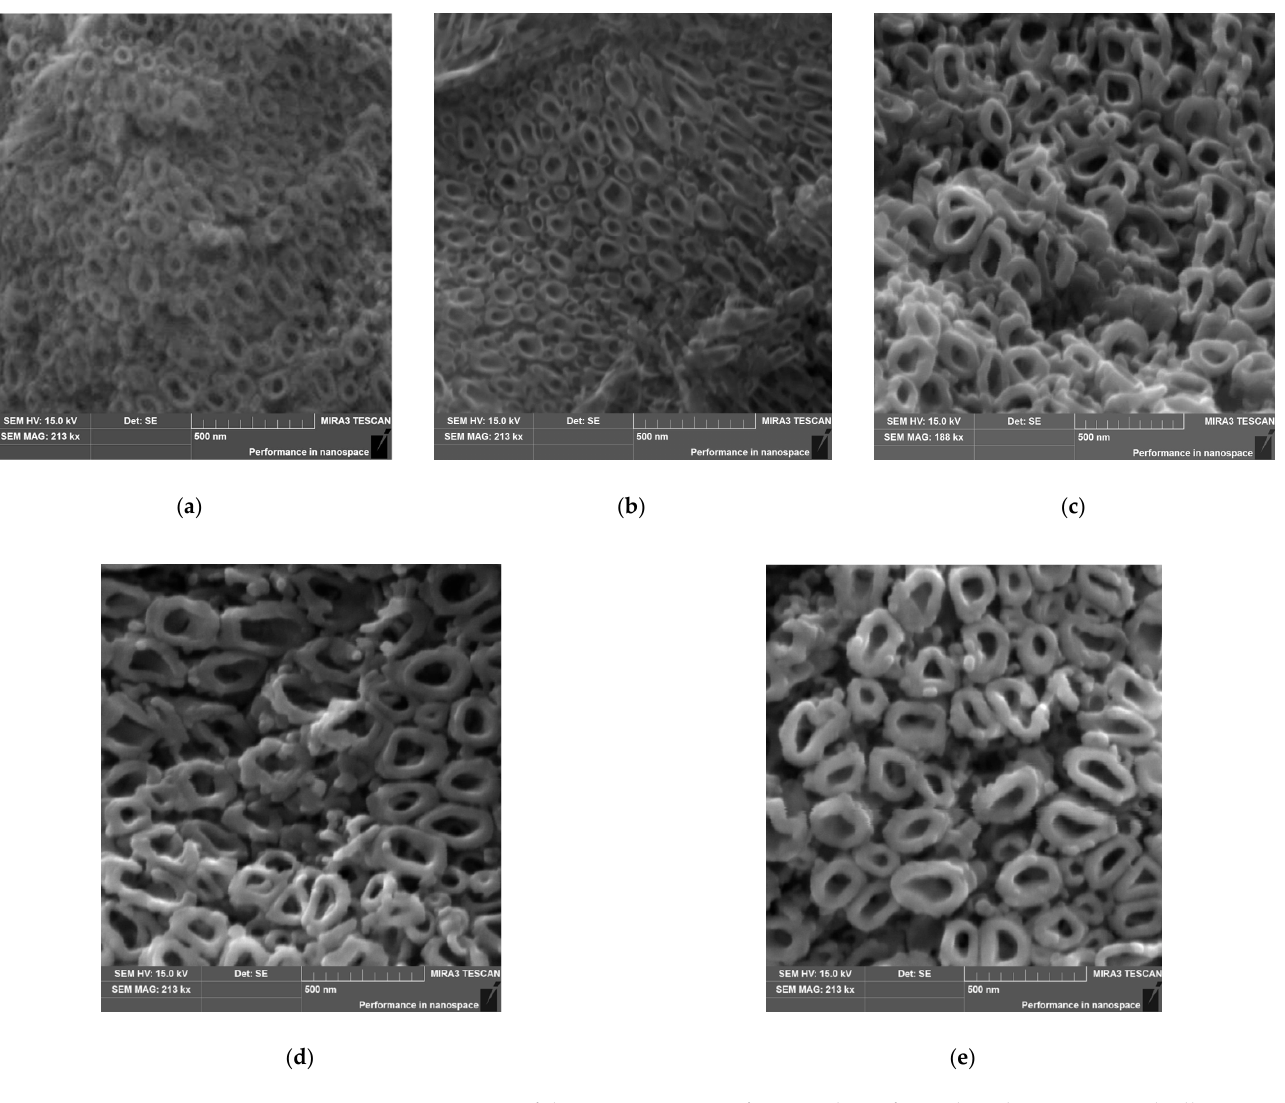
Figure 4. SEM image of the microstructure of SWNTs layer formed on the Ti-13Zr-13Nb alloy in 1 M C 2 H 6 O 2 + 4 wt% NH 4 F electrolyte under anodizing conditions: ( a ) 15 V for 120 min; ( b ) 20 V for 120 min; ( c ) 25 V for 120 min; ( d ) 30 V for 120 min; ( e ) 35 V for 120